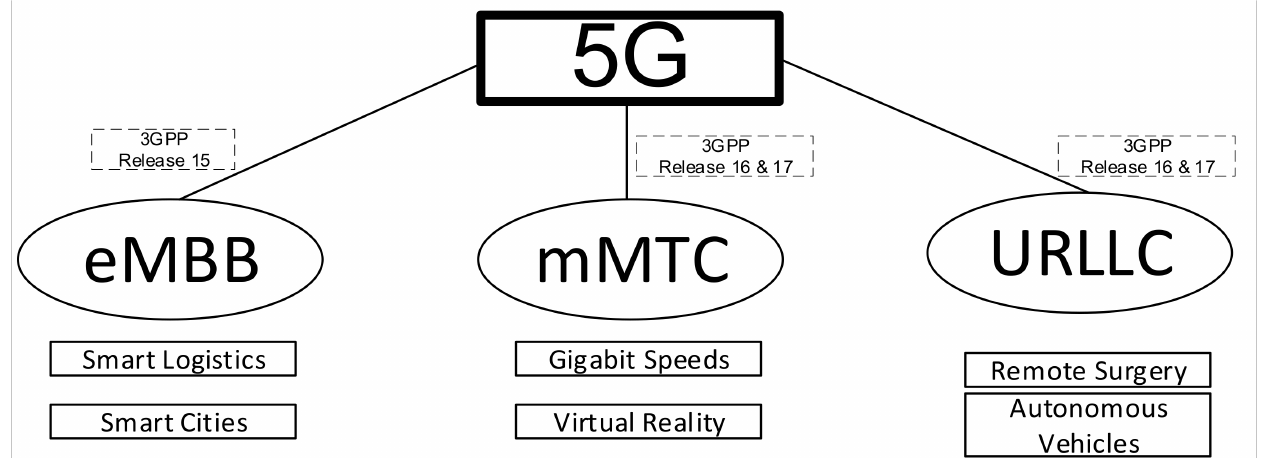
Figure 1. The three groups of 5G use